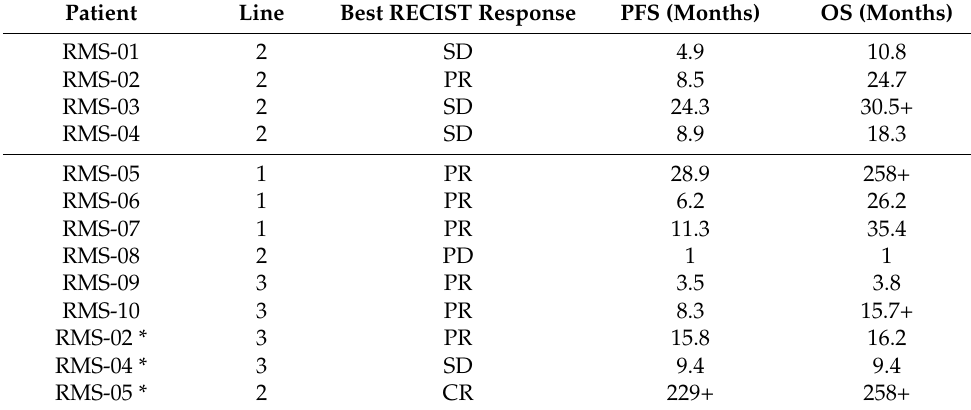
Table 3. RECIST Response. Patient’s outcome on